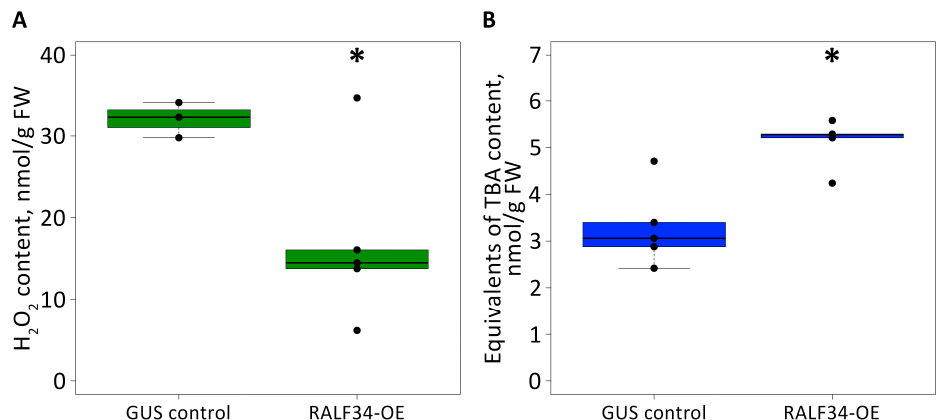
Figure 5. Biochemical characterization of Cucumis sativus transgenic control roots ( p35S::gusA , GUS-control) compared with roots overexpressing CsRALF34 ( p35S::CsRALF34 , RALF34-OE). ( A ) Hydrogen peroxide contents in control roots and roots overexpressing CsRALF34 ; ( B ) contents of thiobarbituric acid-reactive substance (TBARS) in control roots and roots overexpressing CsRALF34 (determined as malondialdehyde equivalents). Asterisks denote statistically significant differences between groups of samples, t -test: p < 0.05. The raw data are summarized in Supplementary Information